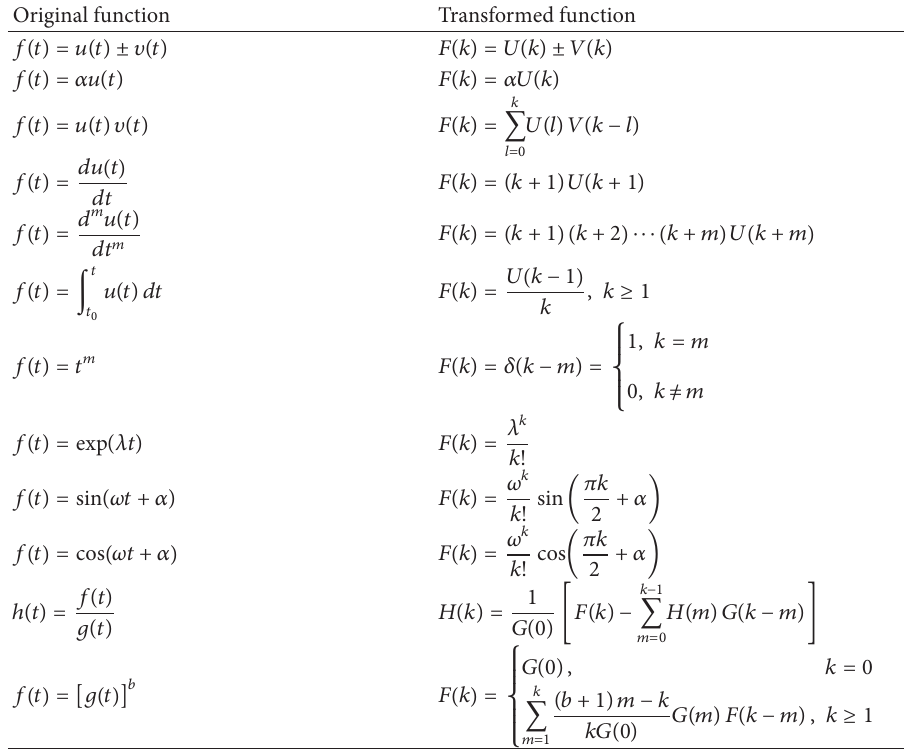
Table 1: Operations of differential